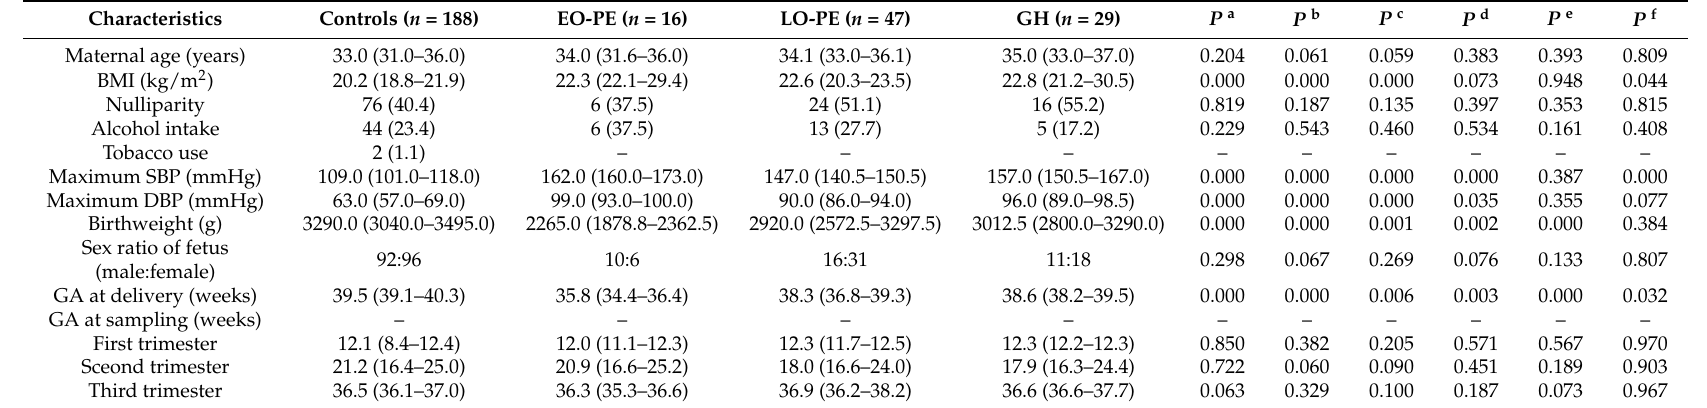
Table 1. Clinical characteristics of the